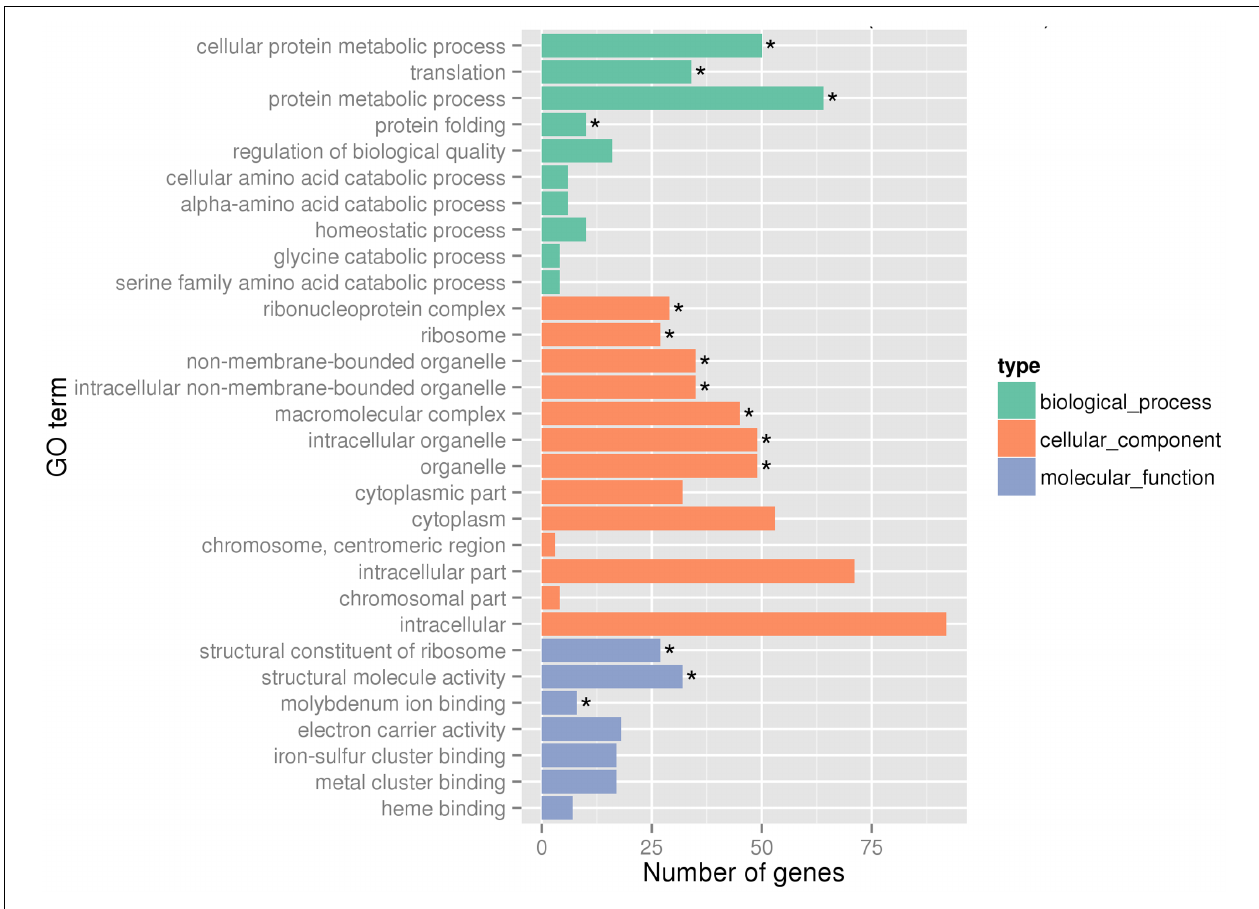
FIGURE 2 | Gene Ontology (GO) terms enrichment at transcriptome level. Asterisks represent significantly enriched GO terms ( P <